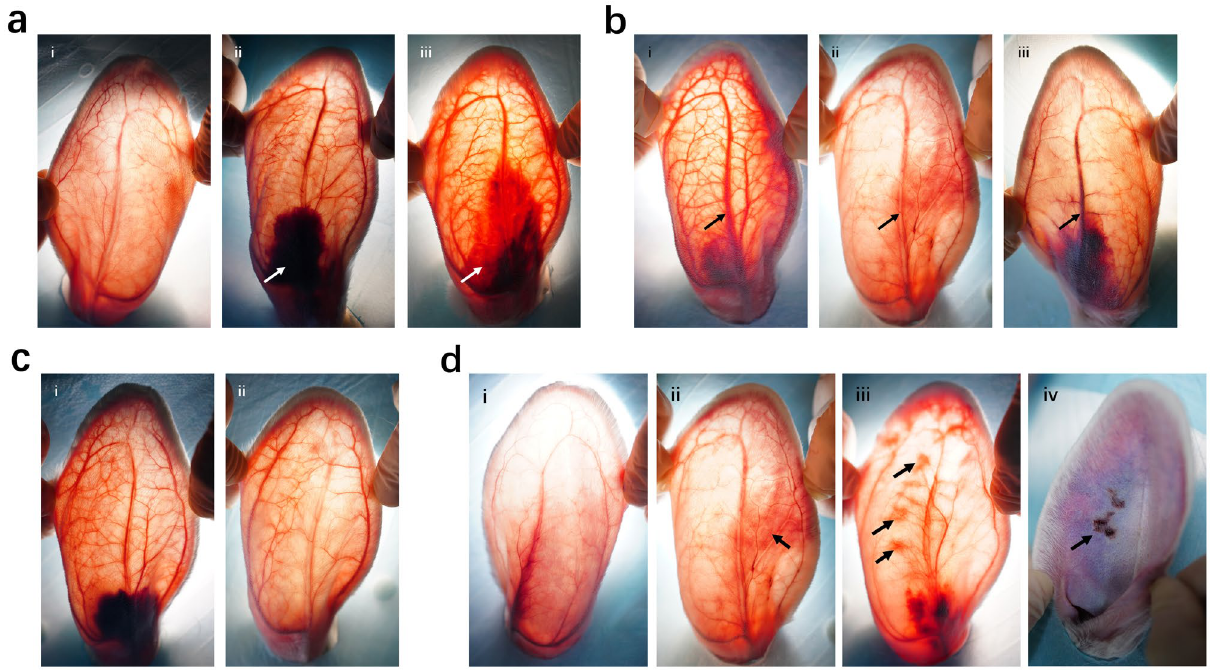
Figure 2. The diagram of observation indexes. ( a ) The formation and regression of hematoma. i: no hematoma; ii: arrow: hematoma; iii: arrow: part of the hematoma regression. ( b ) Vascular recanalization and different types of thrombosis. i: vascular recanalization; ii: arrow: no recanalization with white thrombus; iii: arrow: no recanalization with red thrombus. ( c ) Skin color. i: ruddy; ii: pale. ( d ) Different degrees of tissue necrosis. i: normal; ii: mild necrosis; arrow: erythema. iii: moderate necrosis; arrows: erythema. iv: severe necrosis; arrow: ulceration. Figure was created in Adobe Illustrator software (version 22.1; https:// www. adobe. com/ produ cts/ illus trator.